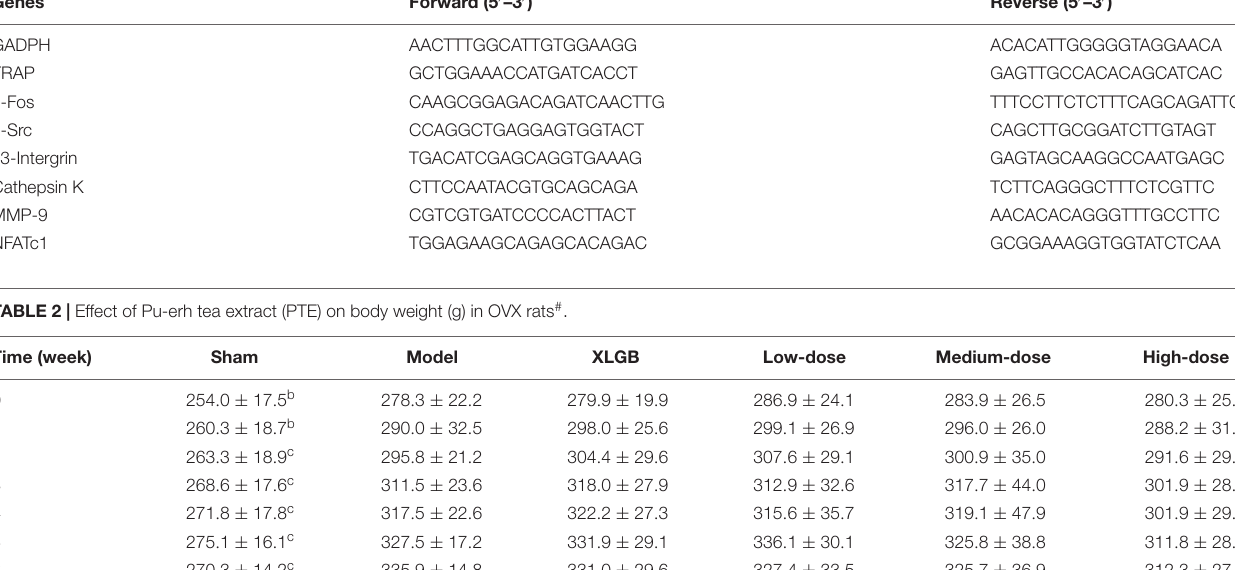
TABLE 1 | Primers used in the qRT-PCR study. Genes Forward (5 (cid:48) –3 (cid:48) ) Reverse (5 (cid:48) –3 (cid:48) )